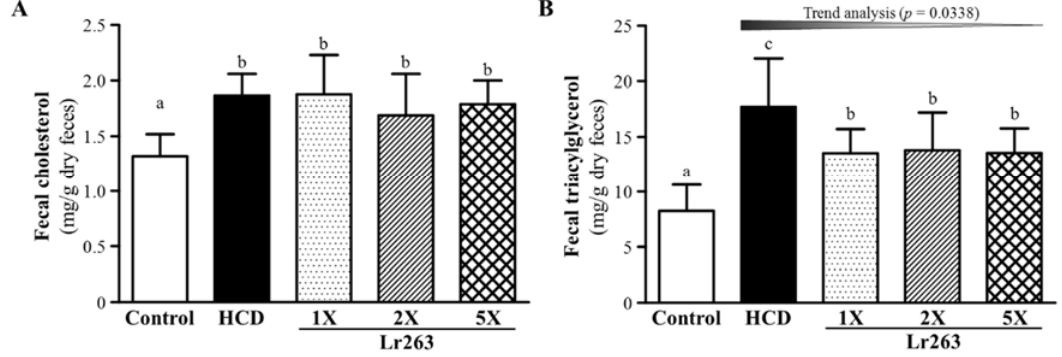
Figure 6. Effect of six-week supplementation with Lr263 on fecal TC ( A ) and TG ( B ) levels in hyperlipidemic hamsters. Data are mean ± SD, n = 8 hamsters in each group.